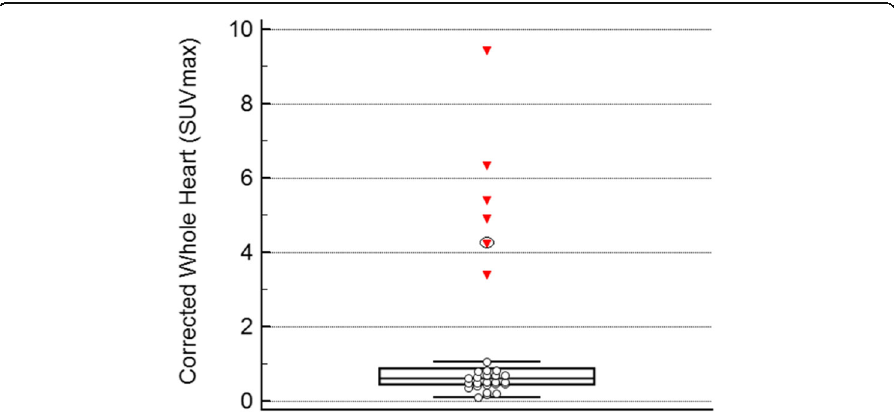
Fig. 6 Graphical representation of whole heart SUVmax corrected for blood pool for all subjects considered as a single population, with associated box and whisker plot showing median and interquartile ranges. Open circles represent subjects without ATTR cardiac amyloid. Closed triangles represent statistical outliers using Tukey ’ s test, and these are the individuals with ATTR cardiac amyloid. Triangle with black ring represents the incidentally identified cardiac ATTR patient with metastatic prostate